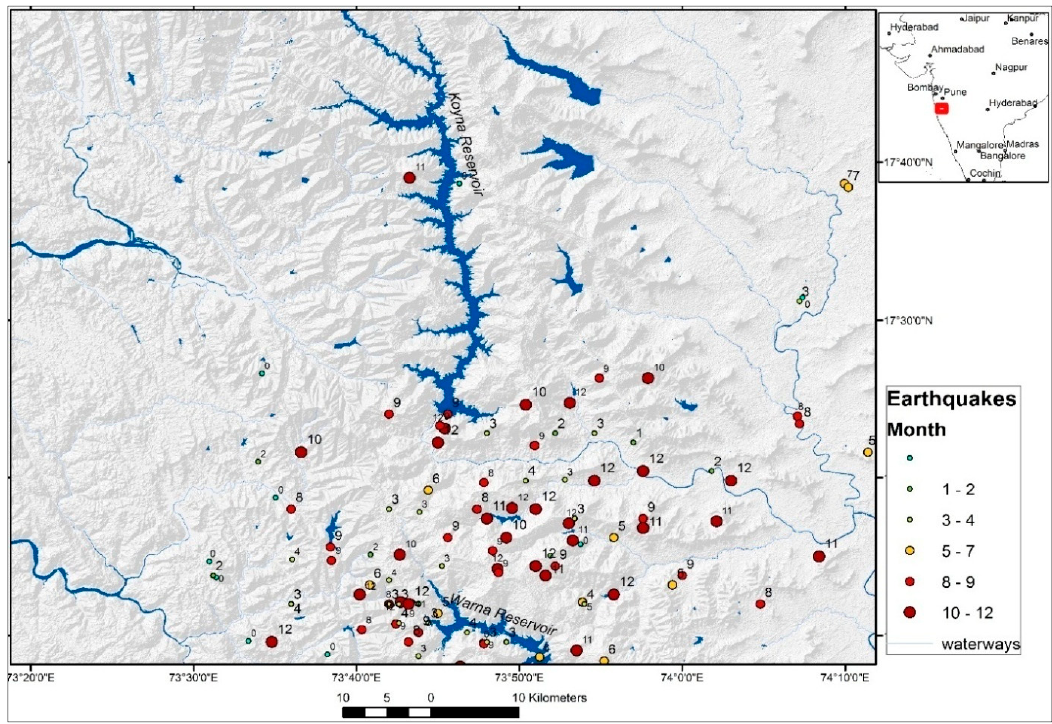
Figure 4. Monthly distribution of earthquakes (0, no record) according to USGS [5], ISC [4], EMSC [6].